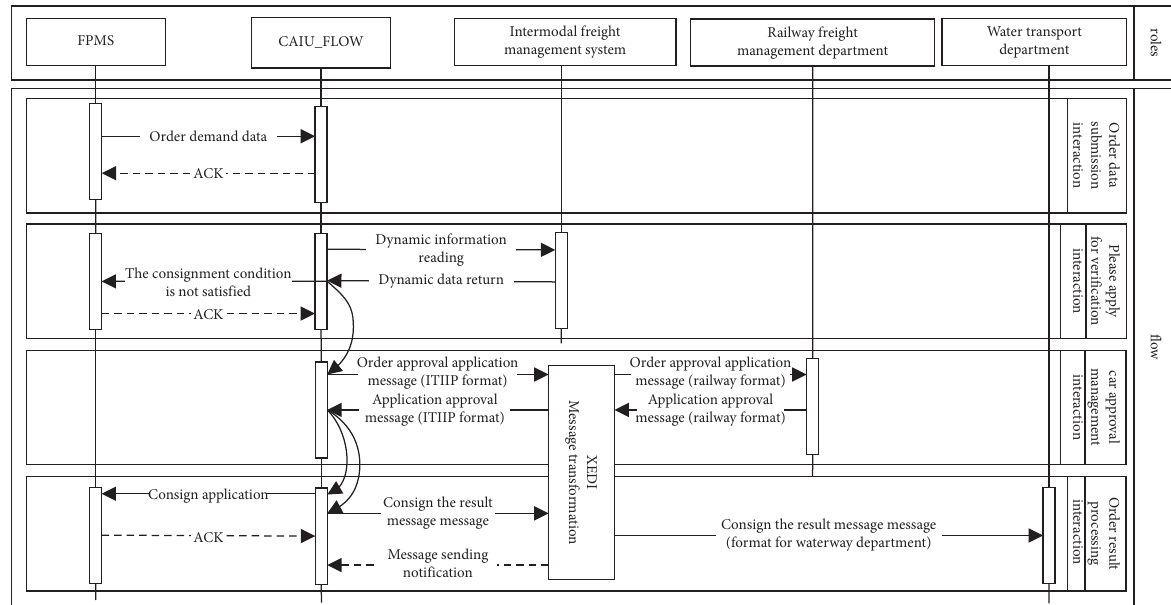
Figure 6: CAIU integrated unit